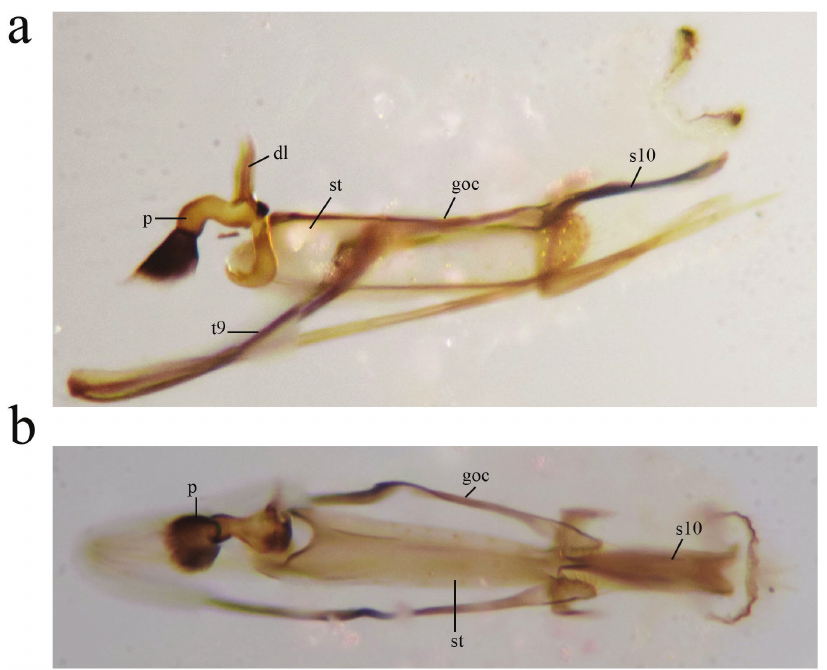
Figure 4. Heteroconis terminalis (Banks, 1913), Guangxi male, genitalia a lateral view. b dorsal view. p, penis; s10, tenth sternite; goc, gonocoxite; dl, dorso-lateral projection of penis; st, stylus; t9, ninth